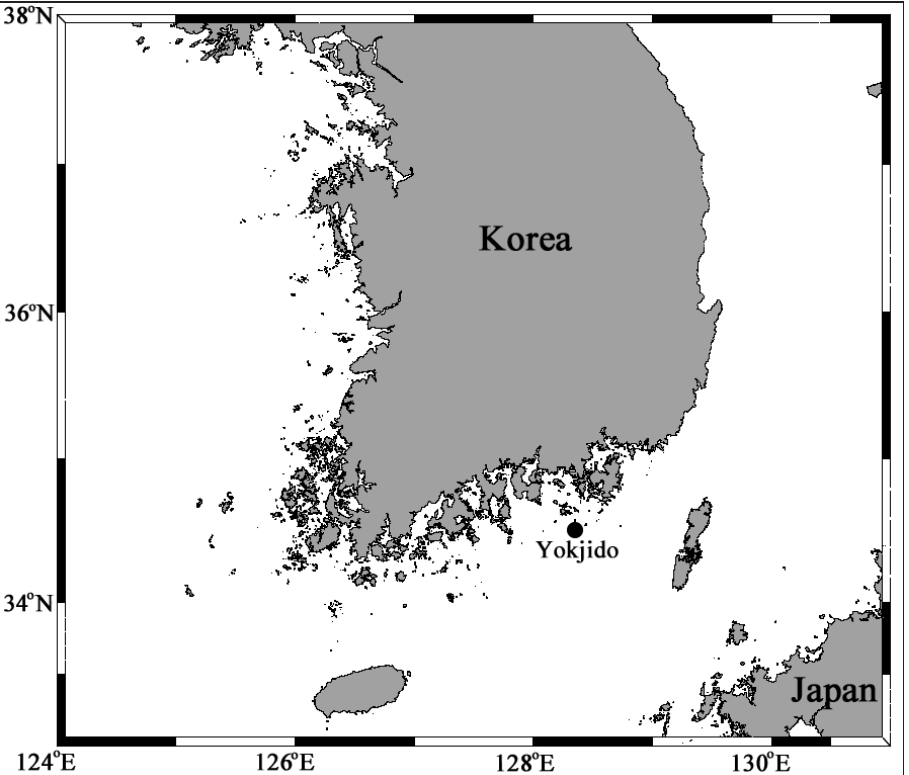
Figure 1. Map of study area with main collection stations